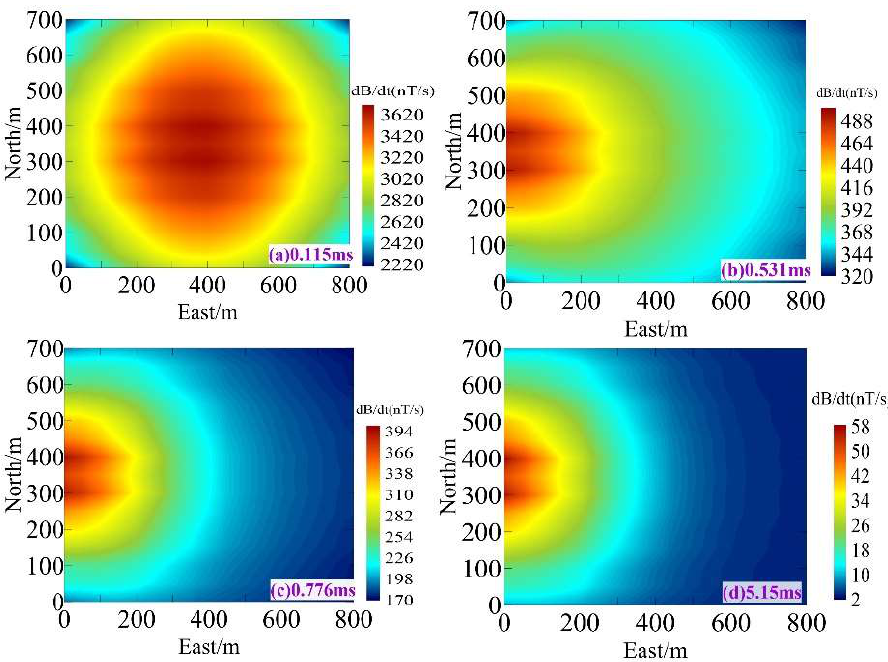
Figure 5. Three-component feature synthesis maps with different sampling times: ( a ) 0.115 ms; ( b ) 0.531 ms; ( c ) 0.776 ms; ( d ) 5.15 ms.